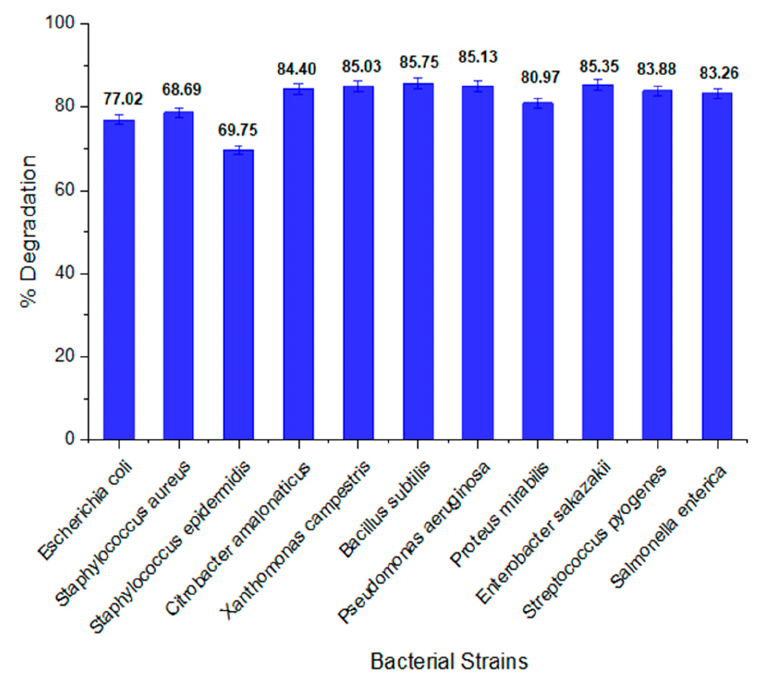
Figure 1. Percentage degradation of orange II by bacterial strains.